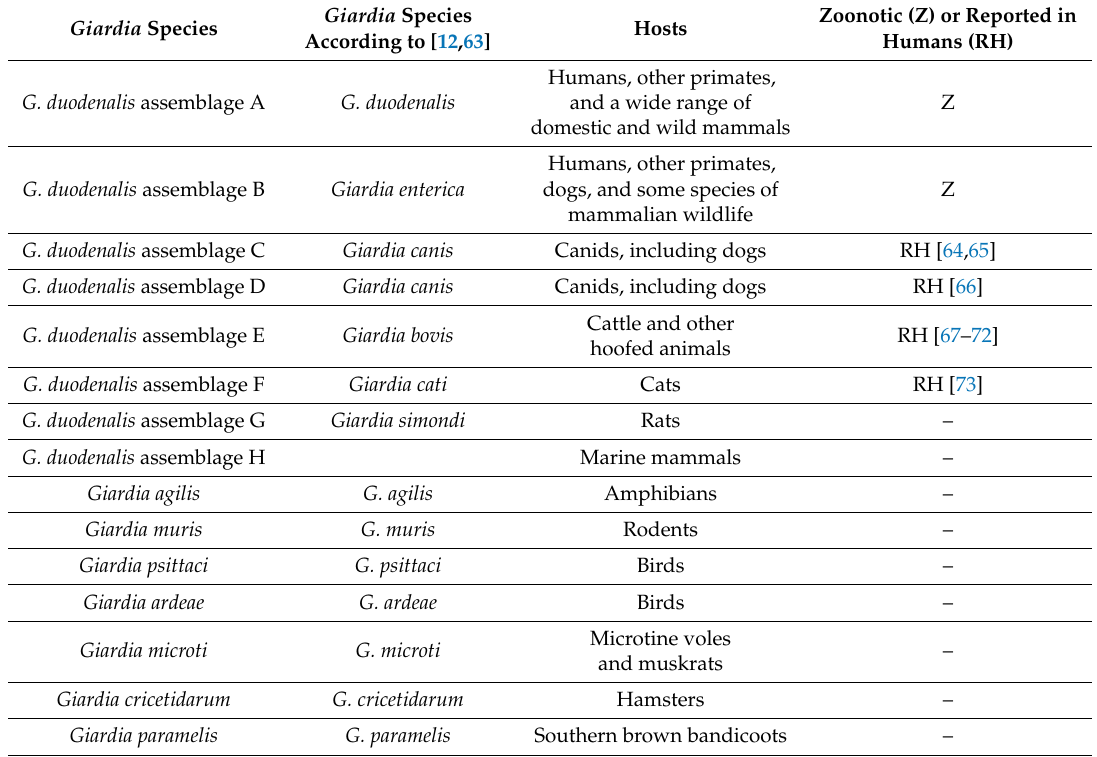
Table 5. Recognized Giardia species, their host range, and zoonotic